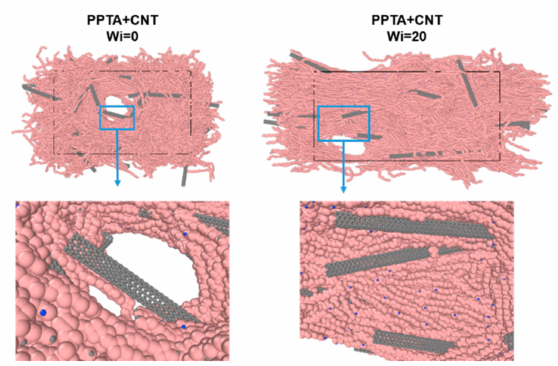
Figure 7. Damage initiated near the CNT reinforcements.